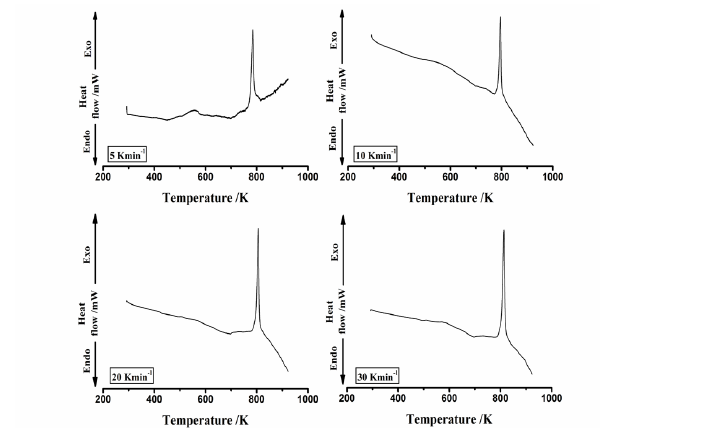
Figure 2 – DSC curves recorded at different heating rates ( β = 5, 10, 20 and 30 K min -1 )